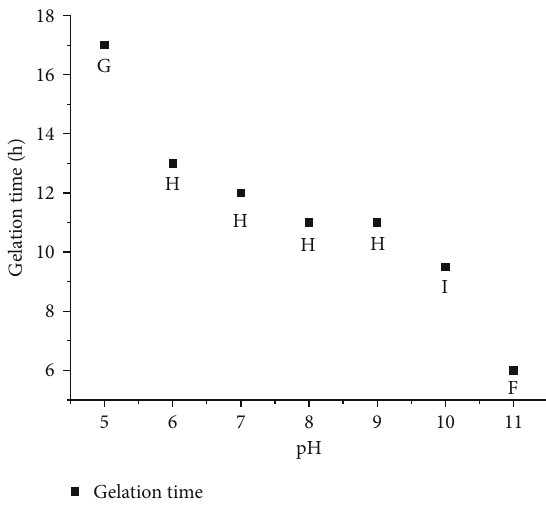
Figure 18: The change trend of gel strength with pH.